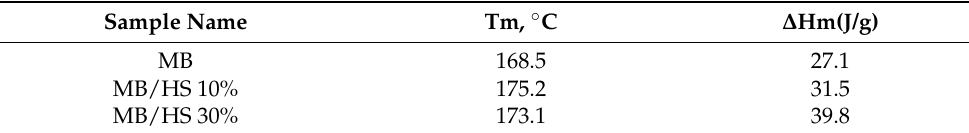
Figure 4. DSC thermograms recorded during the first heating for MB and biocomposites. Table 2. DSC first heating results for MB and biocomposites.